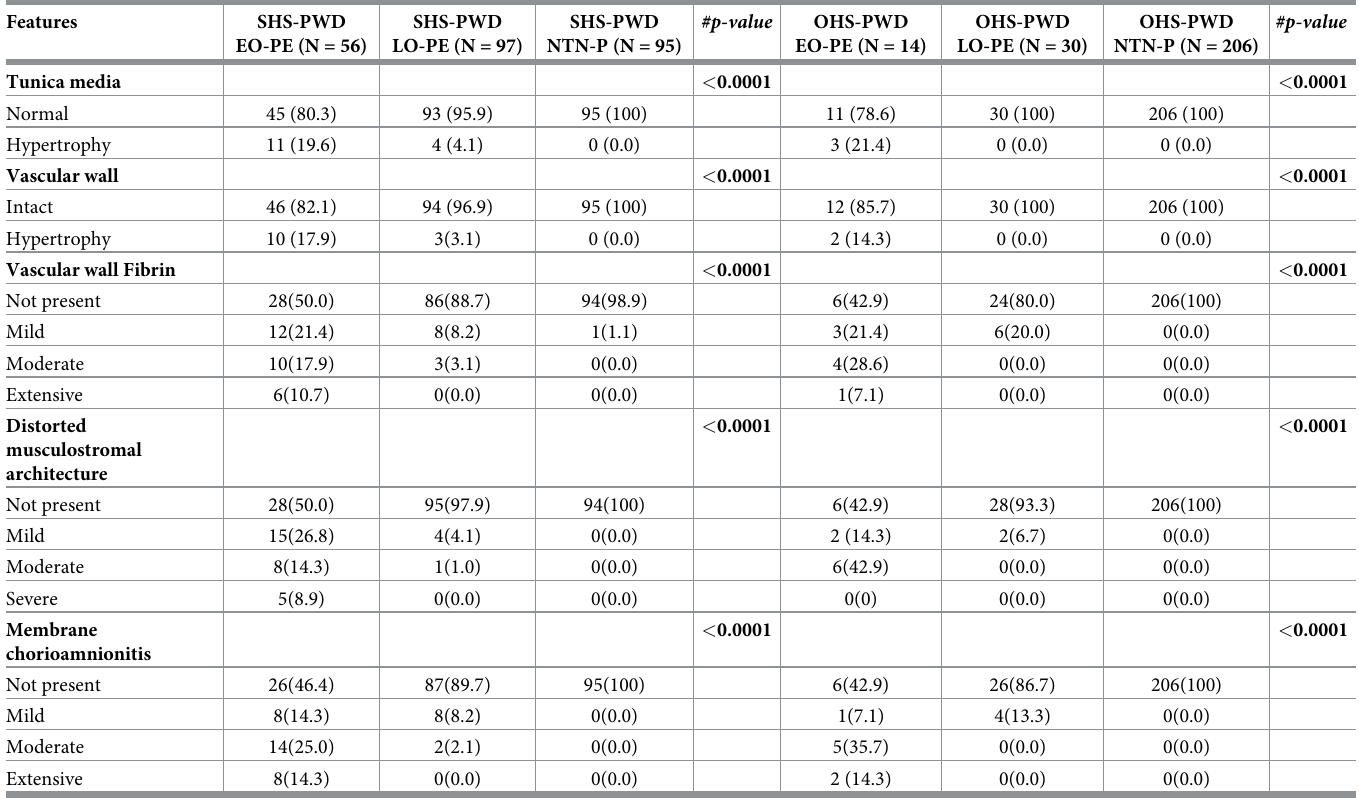
Table 5. Histopathological morphology of placental umbilical cords and membranes among SHS and OHS-PWD EO-PE and LO-PE compared to NTN-P.